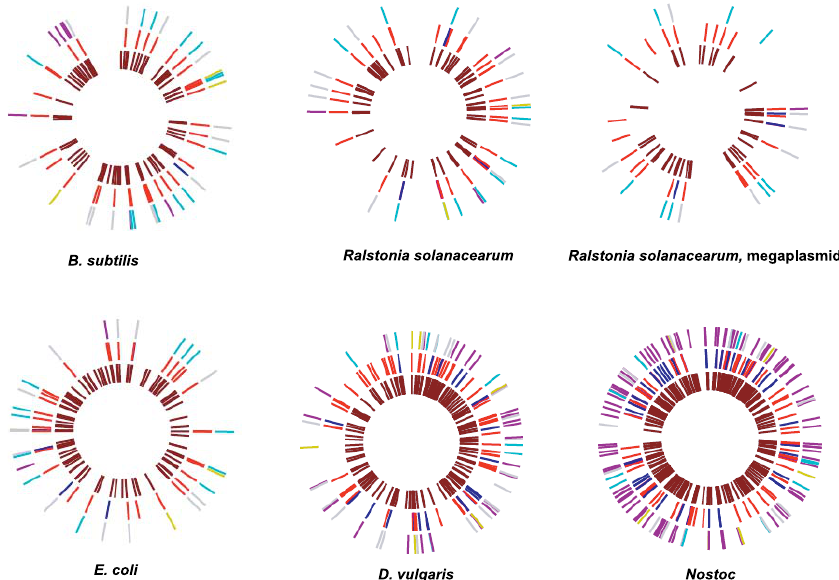
Figure 10. Genomic Distribution of HPKs and RRs The position of signaling proteins in several genomes is shown. In the outer ring, HPKs of different classes are shown: Old (gray), LSE (purple), HGT without duplication (blue), and genes that recently underwent a ‘‘ Birth ’’ event (green). The middle ring shows the position of response regulators, with blue colors indicating hybrid response regulators (containing HPK domains). The inner ring shows the location of all genes in each genome annotated as signaling proteins according to the MicrobesOnline database